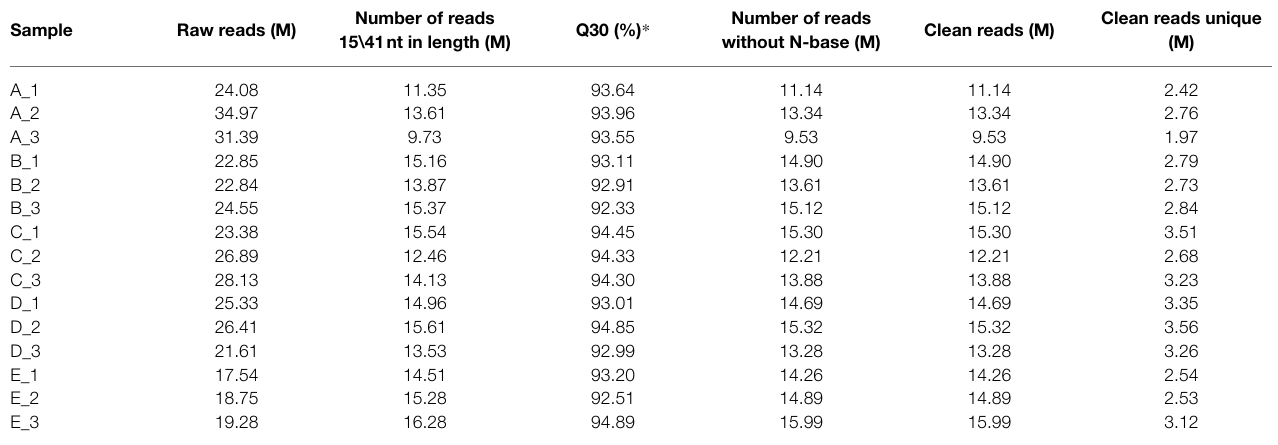
TABLE 1 | Statistical analysis of clean reads.